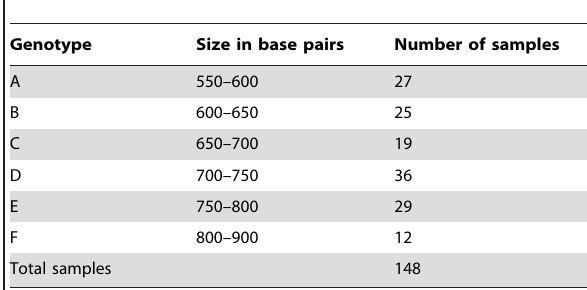
Table 3. pfglurp allelic type detected in the retrospective